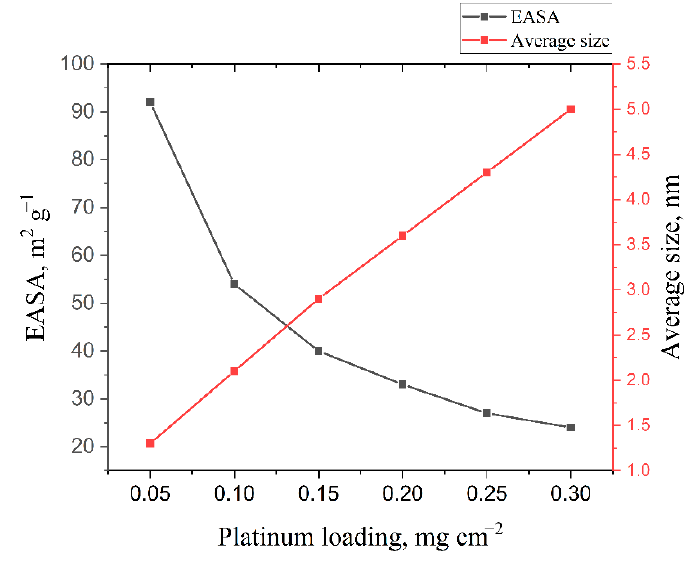
Figure 4. EASA and average particle size as a function of the platinum content of the catalyst.